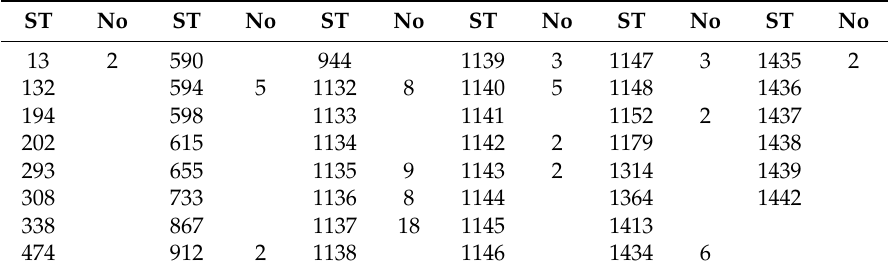
Table 1. Sequence types (ST) of B. pseudomallei strains from Sri